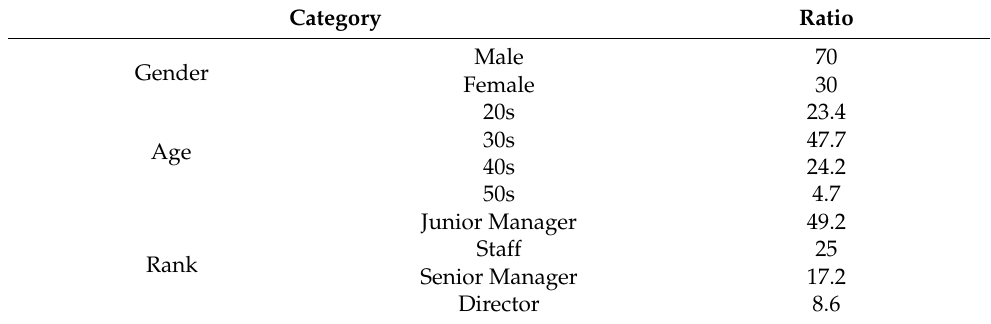
Table 1. Demographic